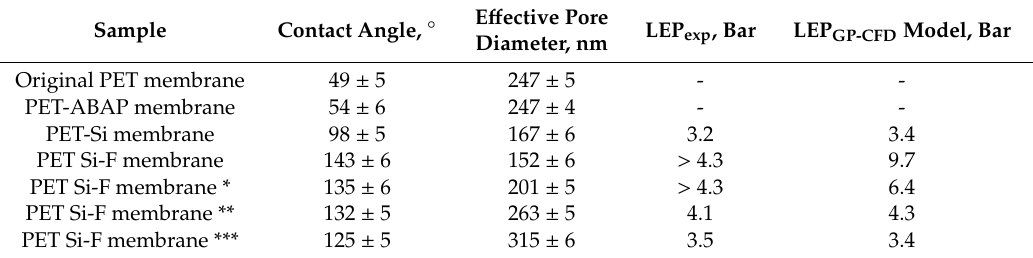
Table 2. Contact angle values and pore sizes for grafted / fluorinated PET TeMs at various stages of modification.